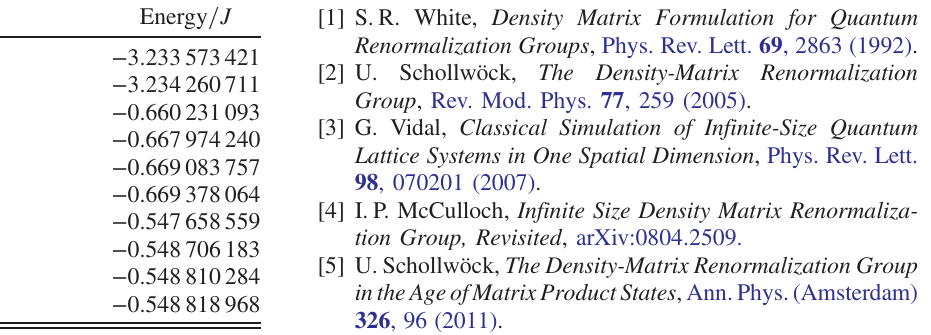
TABLE II. Best variational energies.